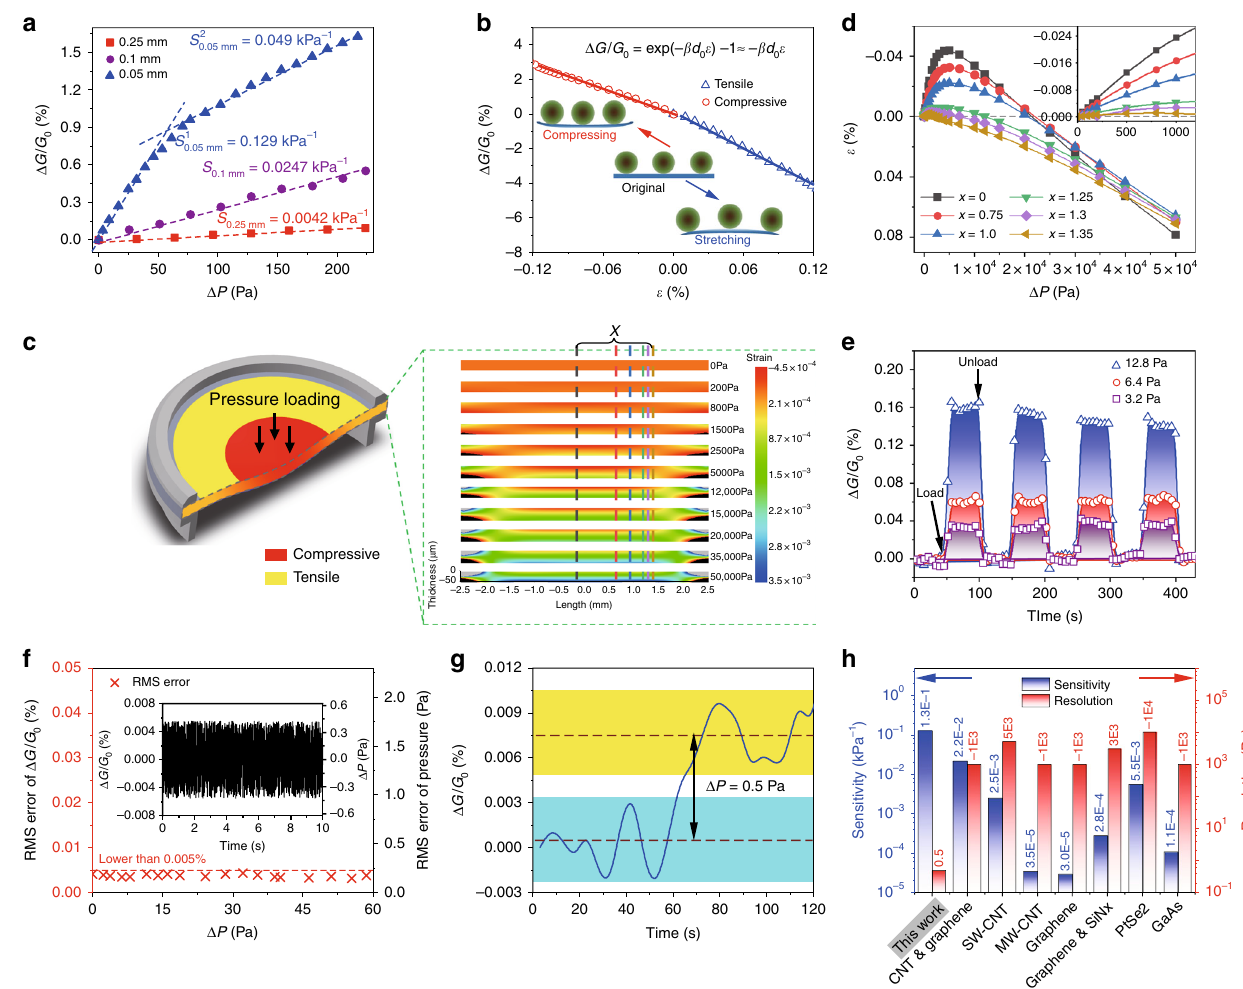
Fig. 2 Detection of tiny differential pressures. a Pressure-response curves for PET membranes of different thicknesses. Error bars represent the s.d. of the conductance. b Δ G / G 0 versus strain ε curves for an actuation layer in the pressure sensor. c The FEA result of the strain distribution on the cross-section along the center line of the PET membrane under different pressures. d Mechanical deformation at various position on the upper surface of the PET membrane. x denotes distance between the center of PET and the point as shown in c . The inset is a partial ampli fi cation of the low pressure regime. e Δ G/ G 0 response of loading and unloading cycles for different pressures. f The RMS error in fl uctuation, which was used to calculate the RMS errors. Both right axes show the pressure converted from left Δ G/G applying Δ P = 0.5 Pa. Data of e , f , and g were from measurements on a sensor with a 0.05-mm-thick PET. h A comparison of the sensitivity and resolution of the present device with other nanostructure-based pressure sensors. Source data are provided as a Source Data fi